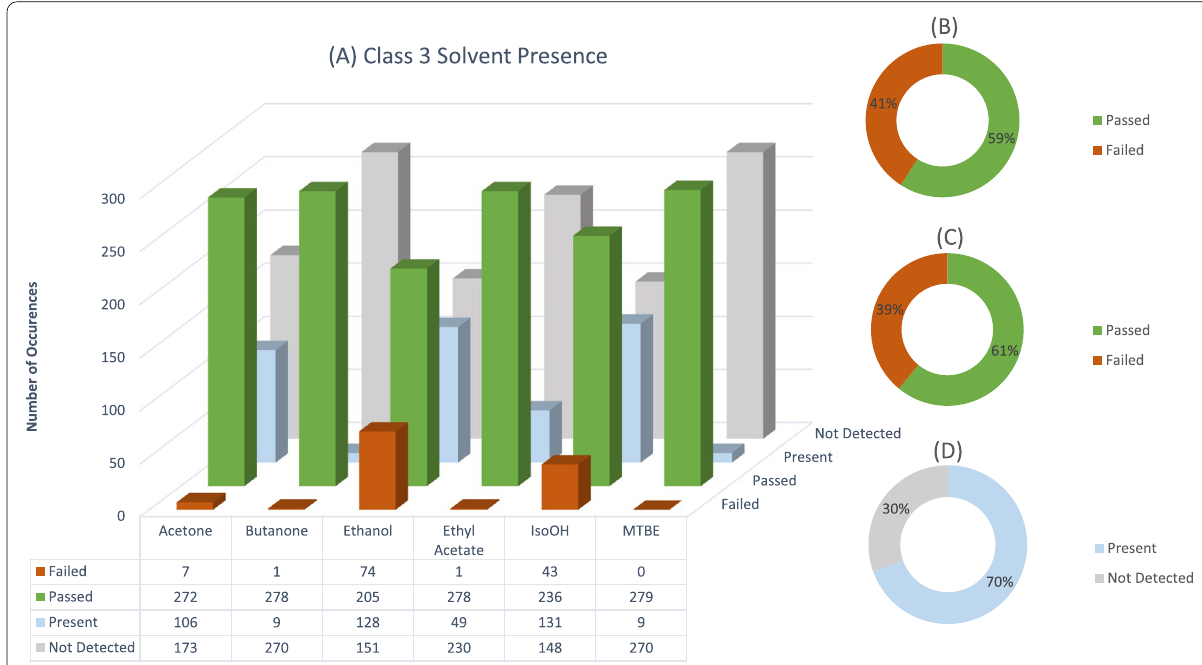
Fig. 2 Number of Individual solvent failure occurrences, and the number of times a class 3 solvent was present ( A )..Total percentage of sample failures for class 3 solvents, if all solvents present in a sample are summed ( B ). Total number of sample failures for all class 3 solvents where one solvent exceeded the limit ( C ). Total percentage of samples for class 3 solvents where any solvent was detected in sample ( D )